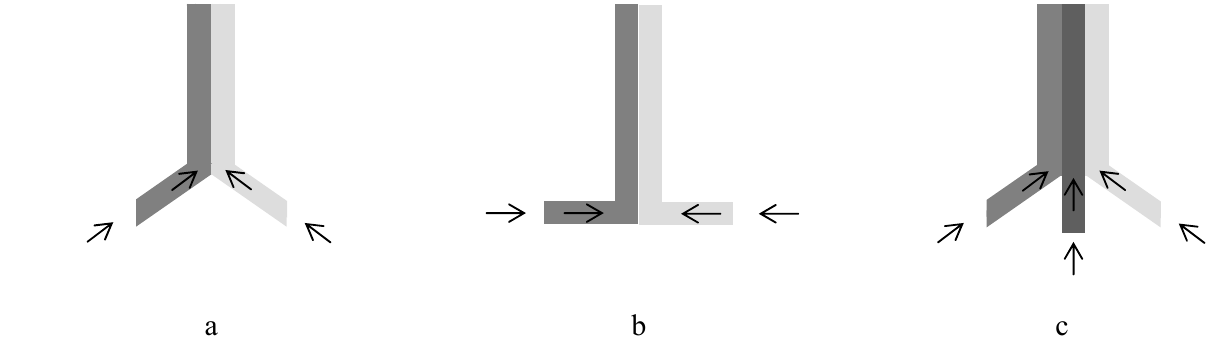
Figure 2. Examples of junctions in microfluidic devices: (a) Y junction; (b) T junction (c)  junction. Arrows suggest direction of